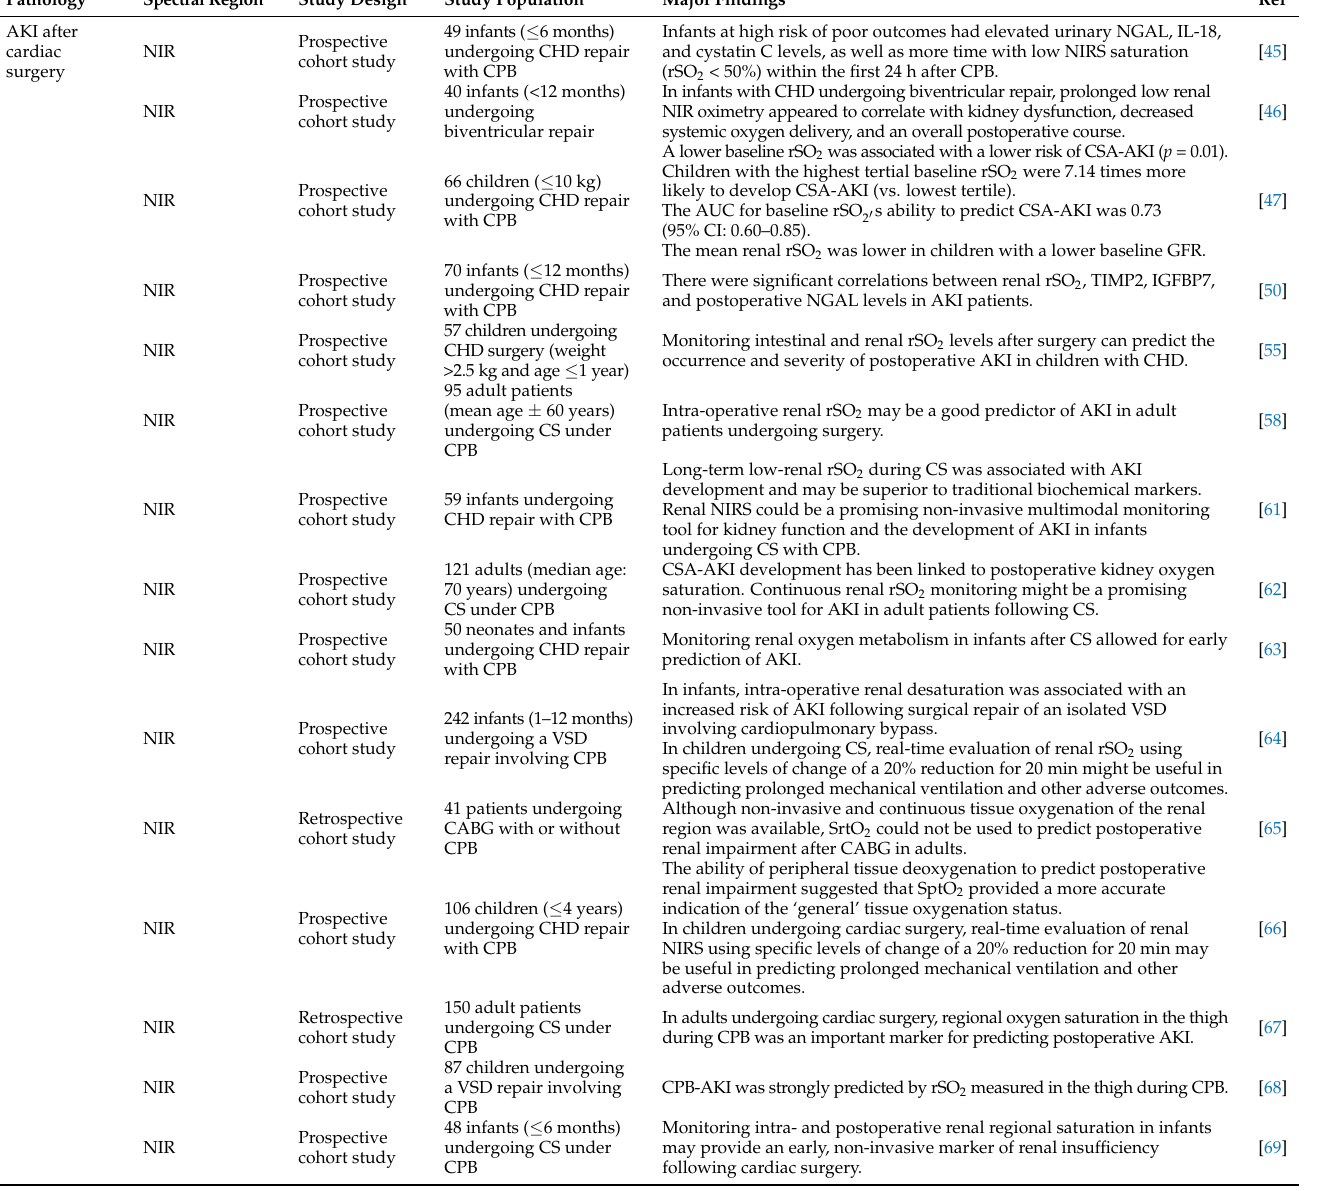
Table 2. Overview of near-infrared and mid-infrared spectroscopy studies in patients with acute kidney injury after cardiac surgery, in preterm infants with acute kidney injury, and in patients with chronic kidney disease, diabetic nephropathy, and glomerulonephritis. AKI: acute kidney injury; ATR-FTIR: attenuated total reflectance-Fourier-transform infrared; AUC: area under the curve; CABG: coronary artery bypass grafting; CHD: congenital heart disease; CI: confidence interval; CKD: chronic kidney disease; CPB: cardiopulmonary bypass; CS: cardiac surgery; CSA-AKI: cardiac-surgery- associated acute kidney injury; DN: diabetic nephropathy; (e)GFR: (estimated) glomerular filtration rate; GN: glomerulonephritis; HCs: healthy controls; HbA1c: hemoglobin A1c; HR: hazard ratio; IGFBP7: insulin-like growth-factor-binding protein 7; IL-18: interleukin-18; i.o.: intra-operatively; IR: infrared; KDIGO: kidney disease: improving global outcomes; MIR: mid-infrared; NIR(S): near-infrared (spectroscopy); NL: normal kidneys; NLD: normal kidneys of diabetic individuals; rSO 2 : regional